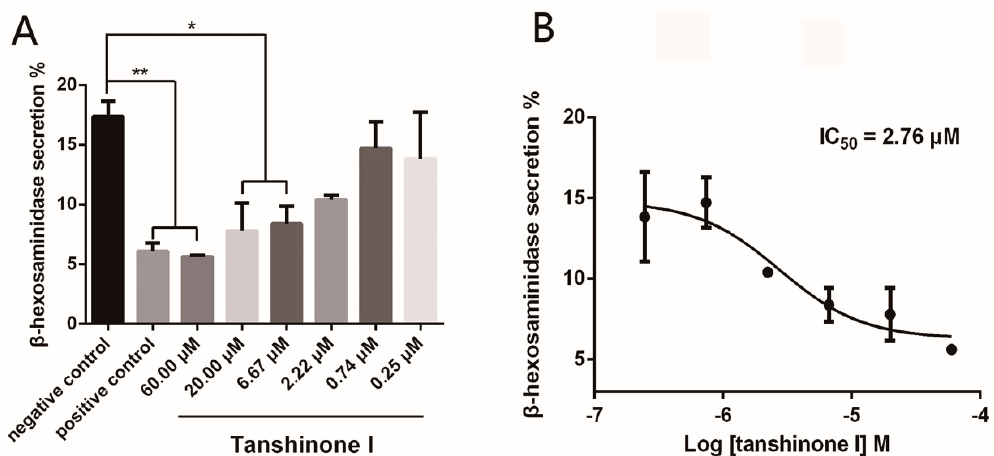
Figure 5. The inhibition of Syk activity by different concentrations of tanshinone I ( A ) and dose-response curve analysis ( B ). All error bars represent the SE of thethree replicates. ** means p < 0.01 and * means p < 0.05.